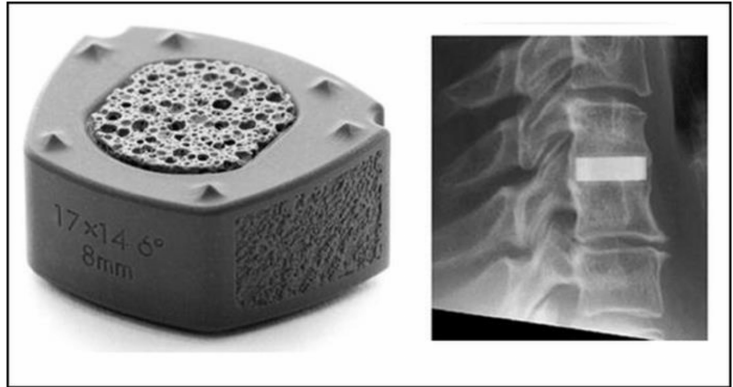
Figure 4. Silicon nitride cervical interbody fusion device (Valeo CCsC ® , left) with the radiographic image of the implanted device (right) [30]. © Creative Commons Attribution 4.0 International